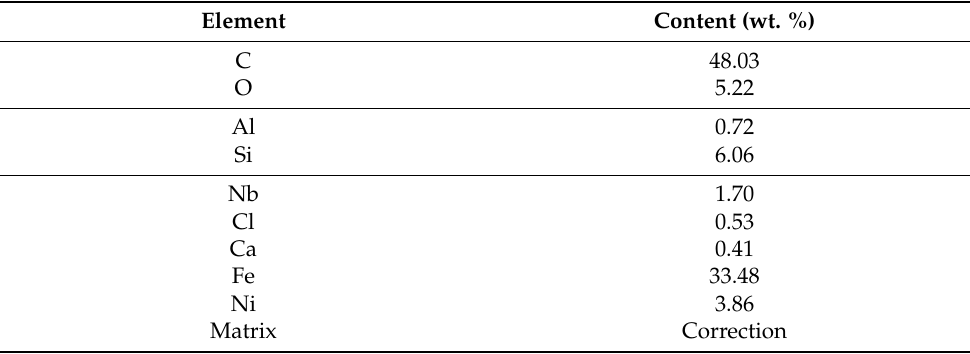
Figure 2. Structure of the composite medium with 3.8% Fe-Si-Nb-Cu-B flakes + 2% CNT ( a ); the section of the composite on which the energy dispersive analysis was performed ( b ); the result of energy dispersive analysis ( c ). Table 1. The content of elements in a Finemet alloy particle.